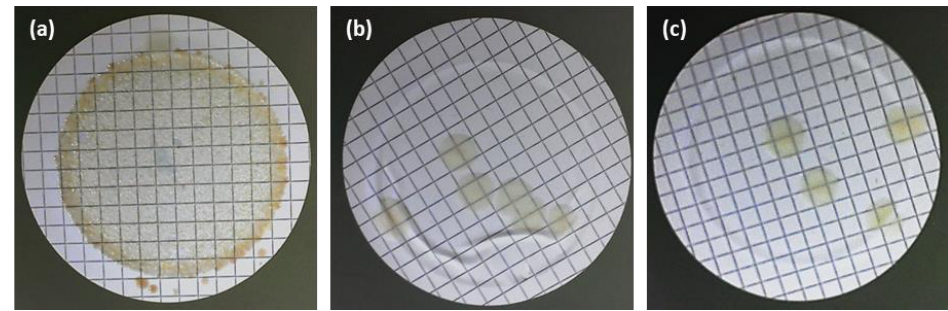
Figure 16. Inhibition growth test of microorganisms in water with membranes. ( a ) Silver-free membranes (CA30); ( b ) CA/Ag membranes with 0.1%wt Ag (CA30Ag0.1); and ( c ) CA/Ag membranes with 0.4%wt Ag (CA30Ag0.4).